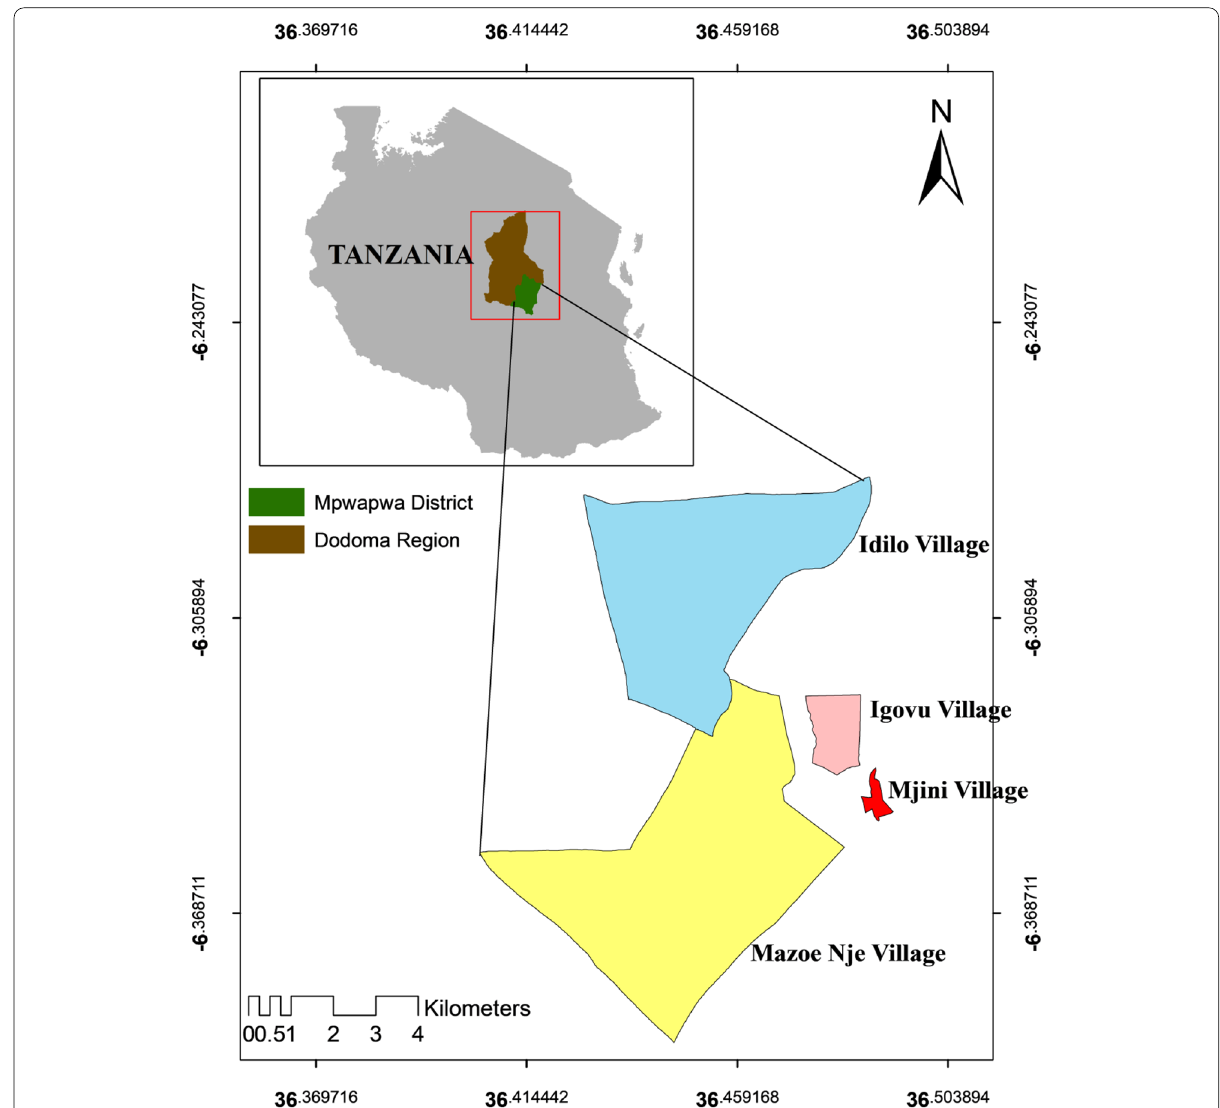
Fig. 1 The four study villages in the Mpwapwa District,